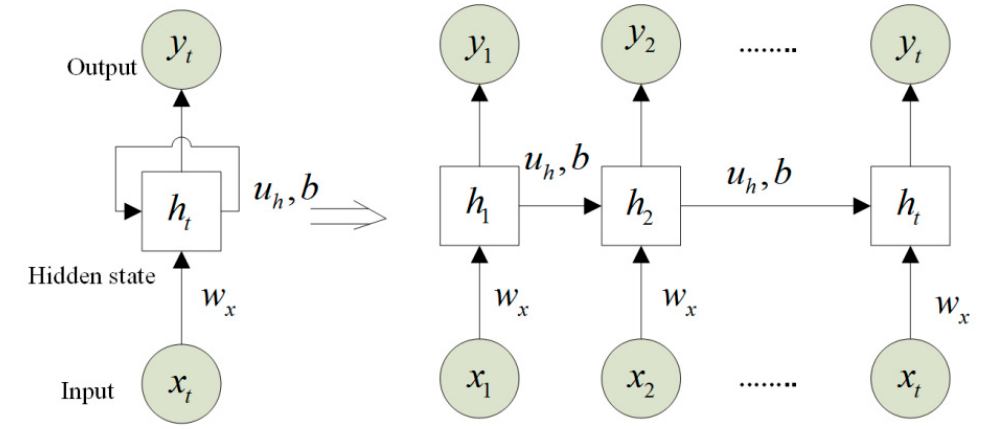
Figure 2. The architecture of a recurrent neural network.